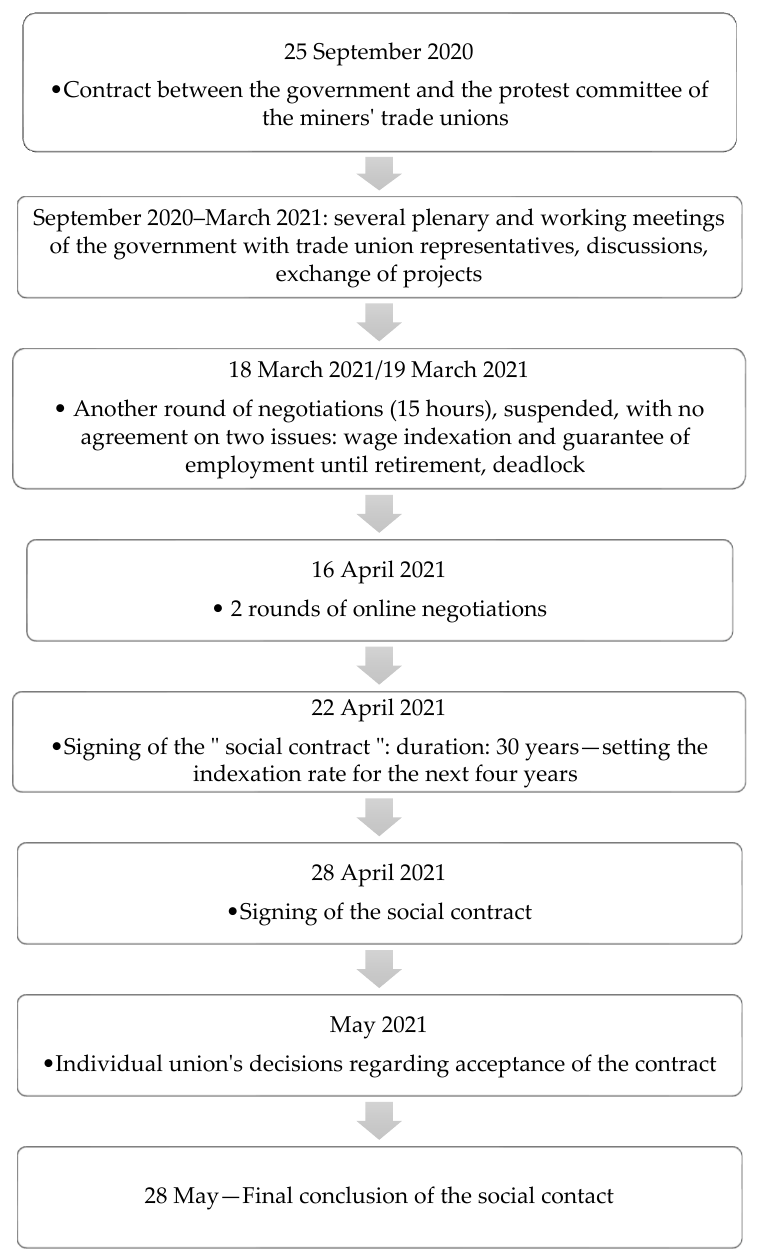
Figure 1. Timeline of the government’s negotiations of the social contract with the miners’ trade unions. Source: author’s own compilation.